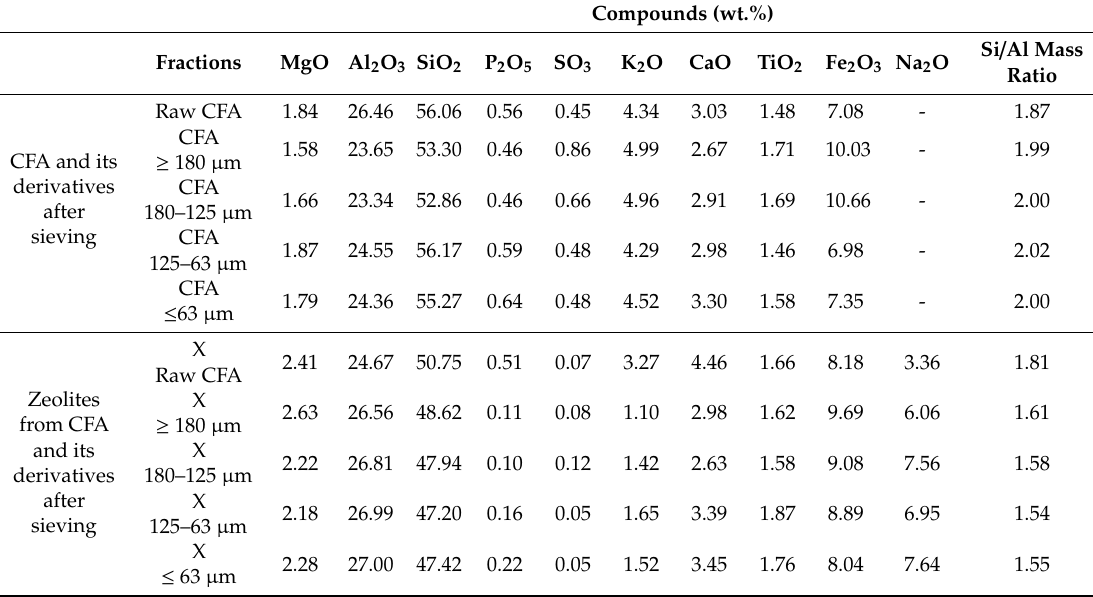
Table 2. Chemical composition of fly ashes and